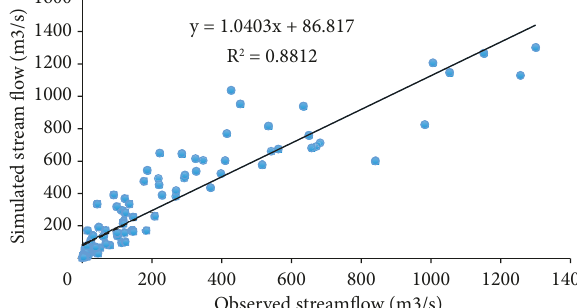
Figure 12: Scatter plots of observed and simulated daily streamflow for the Nashe watershed during the validation period.